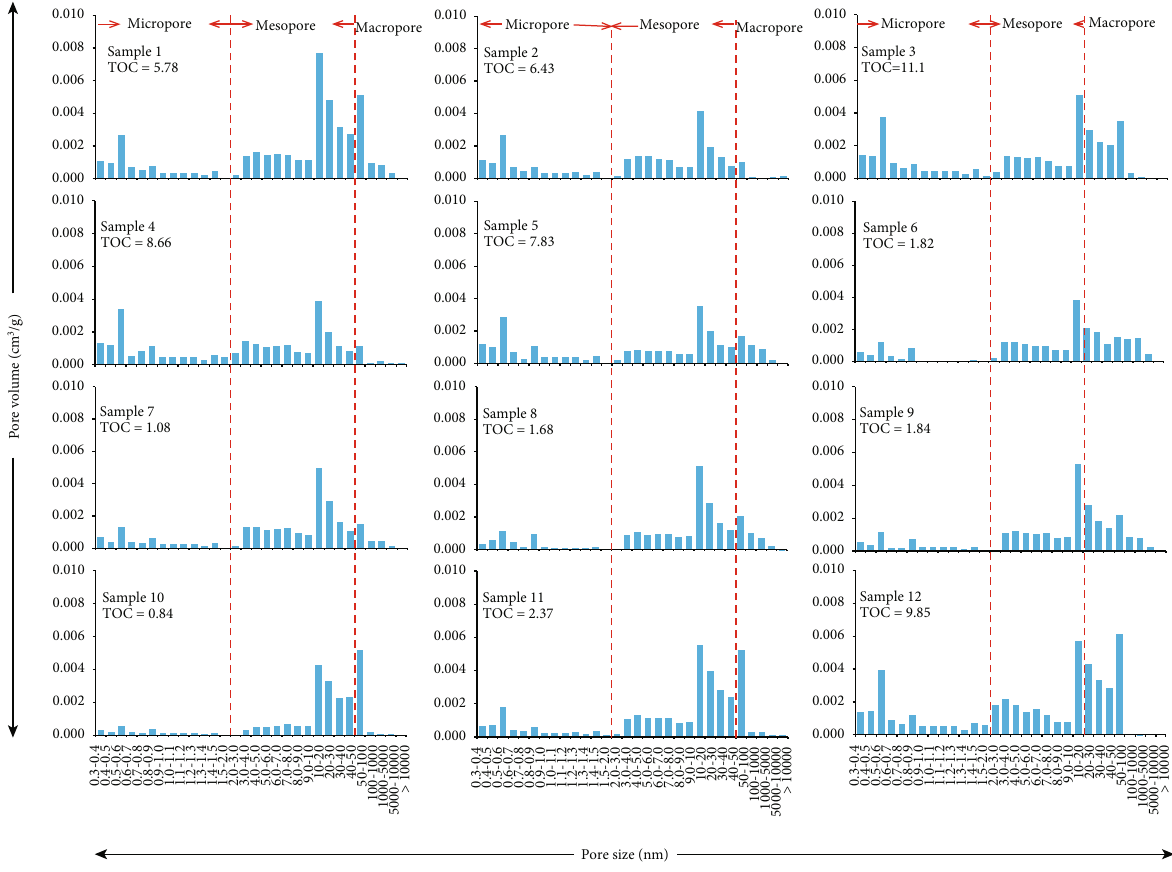
Figure 6: Histogram of complete PV distribution of shale samples. Table 3: Statistical results of pore volume of shale